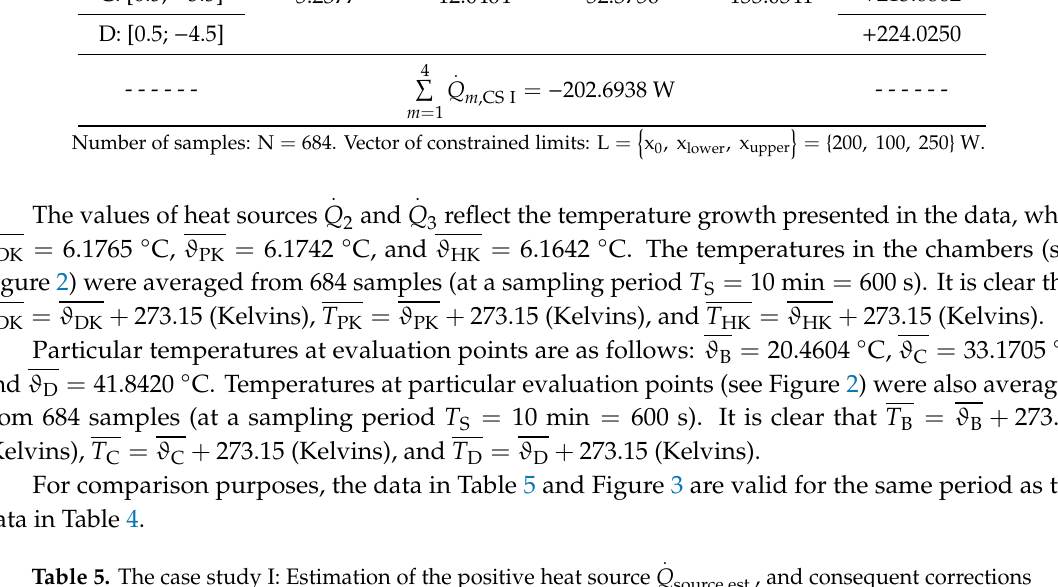
. Q source,est. , and consequent corrections